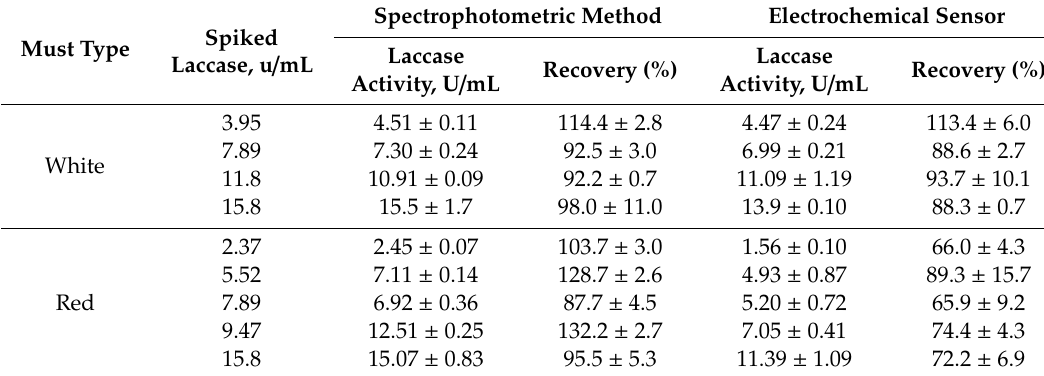
Table 2. Measurements of laccase activity in grape must with the electrochemical sensor with ABTS and using the spectrophotometric method with